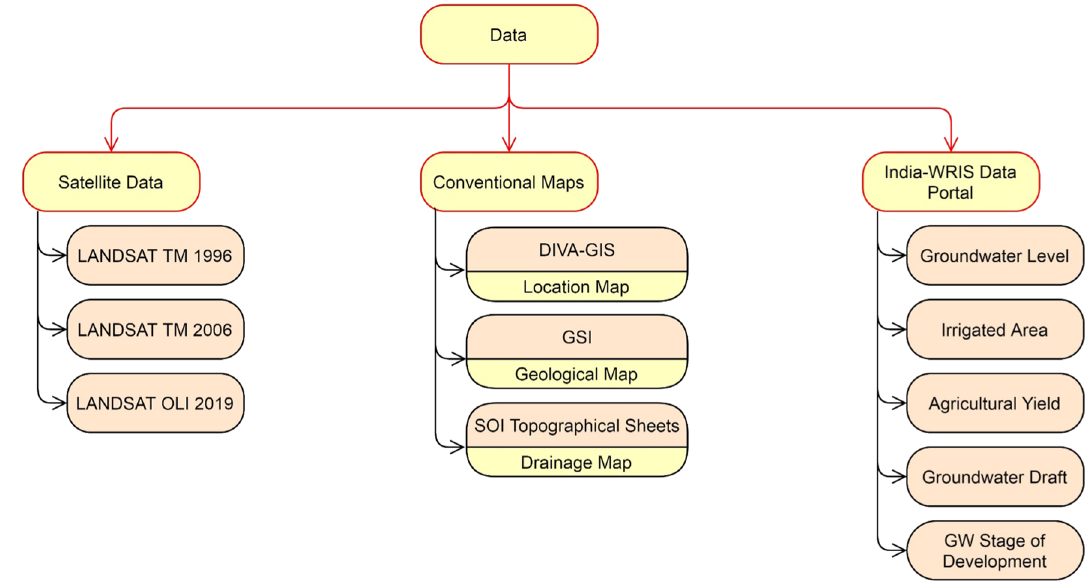
Fig. 4 Flow chart of database and their